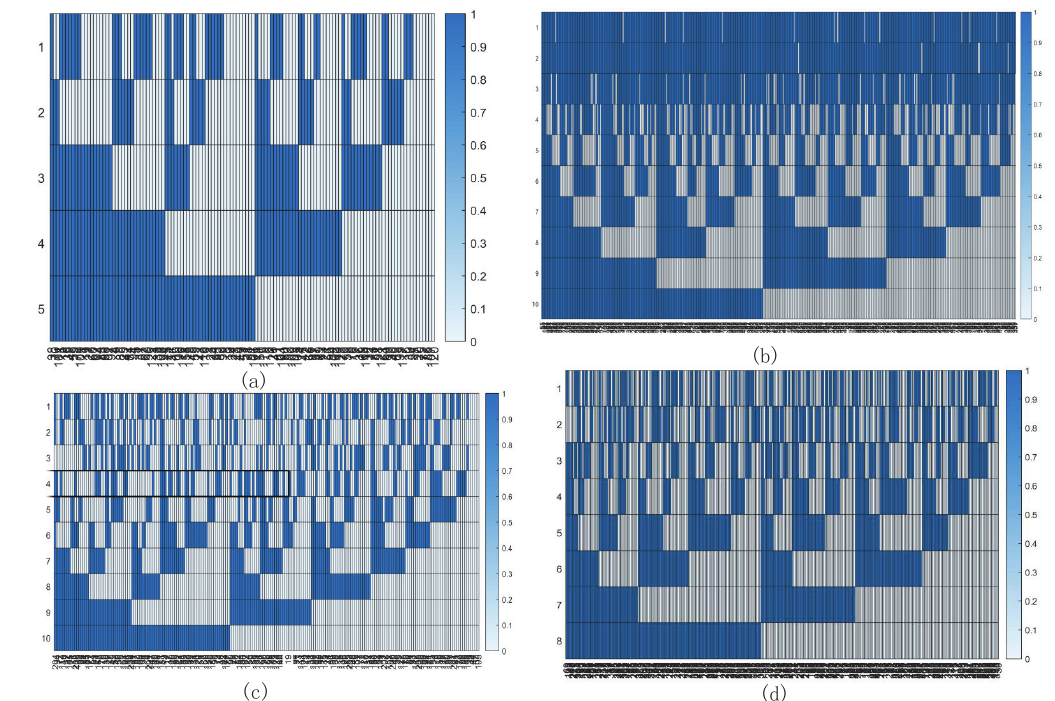
Figure 5. Visualization of linear group (marked as 1) in each embedding dimension with a sorting. ( a ) AUL8, ( b ) DJI, ( c ) GEI and ( d )